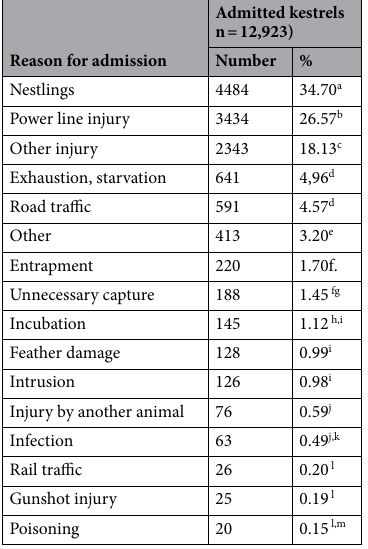
Table 1. Number and percentage of the total number of common kestrels admitted to rehabilitation centres from 2010 to 2019 according to the reason for their admission. a-m The values with different superscript letters in a column are significantly different ( P < 0.05).